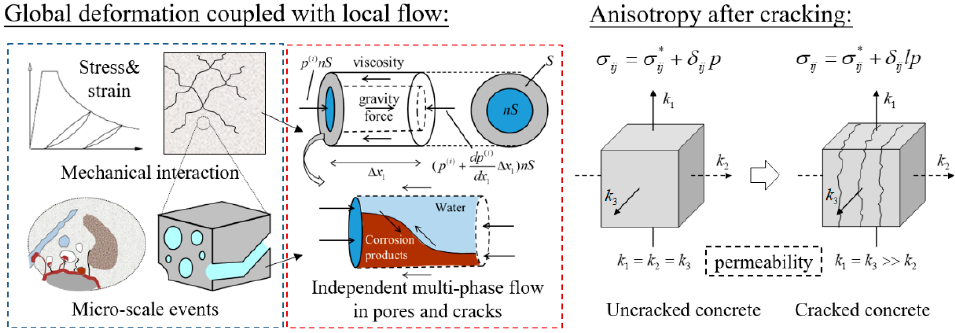
Figure 3. Transport of corrosion products in the pores and dynamic equilibrium of the system.